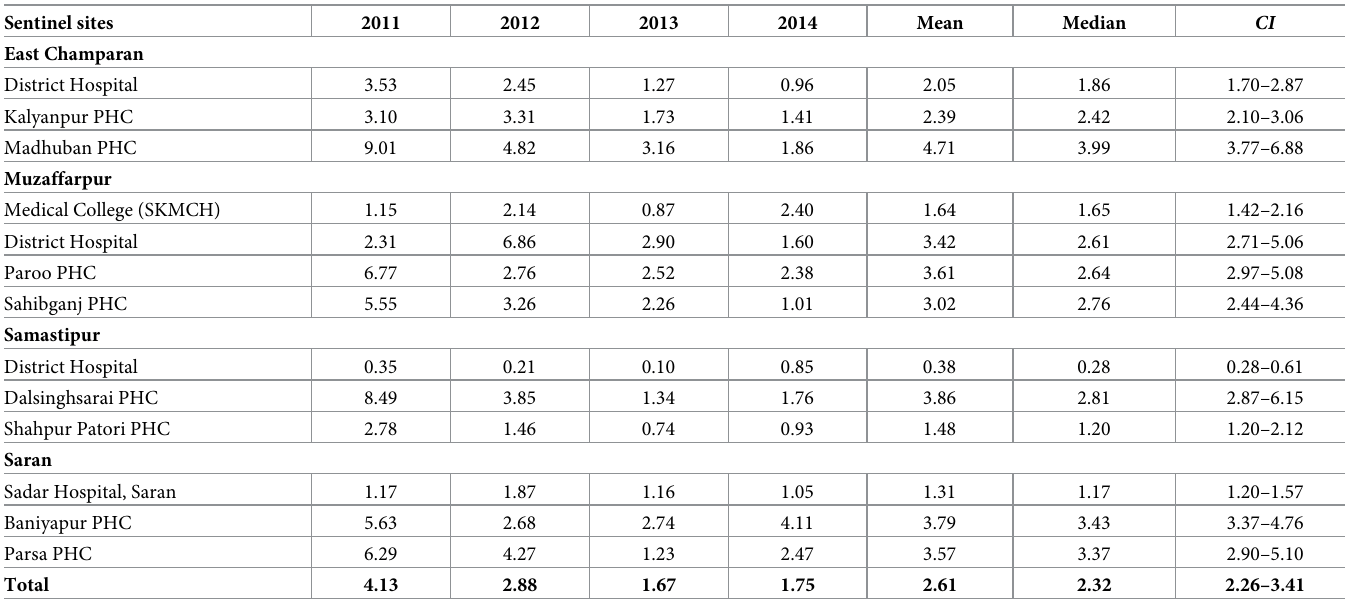
Table 1. Sentinel site-wise kala-azar incidence/10,000